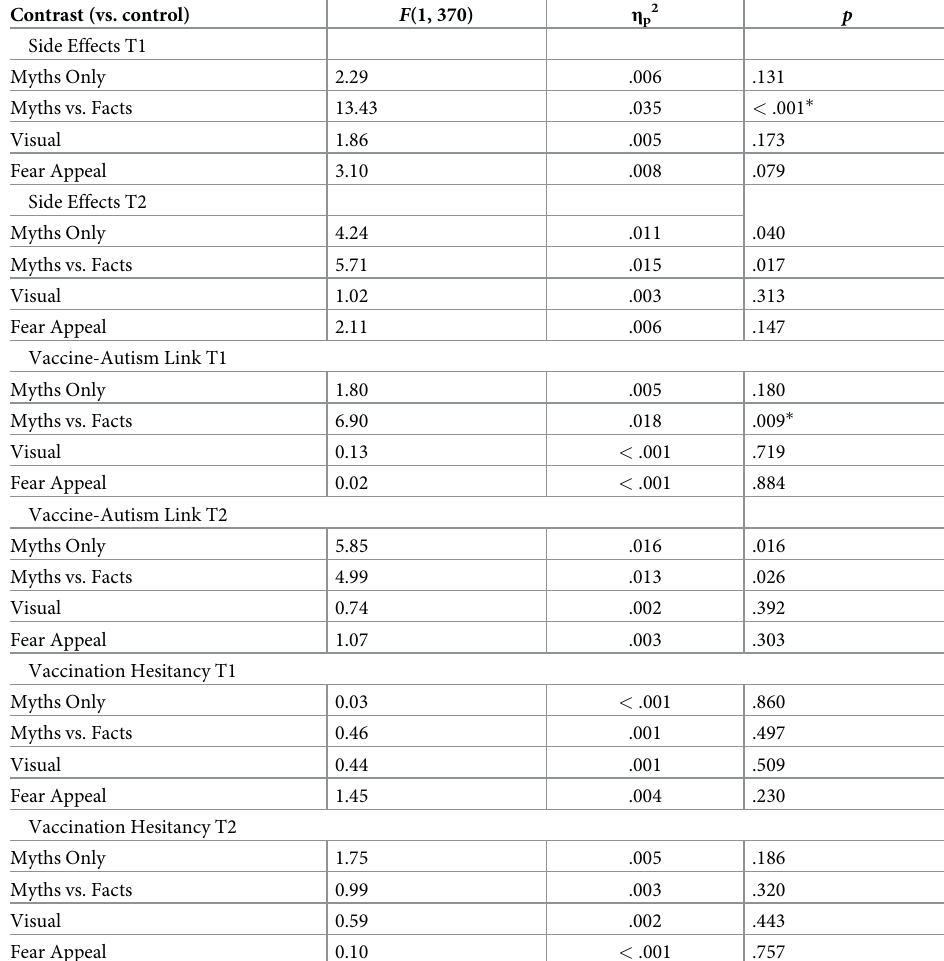
Table 1. Contrast